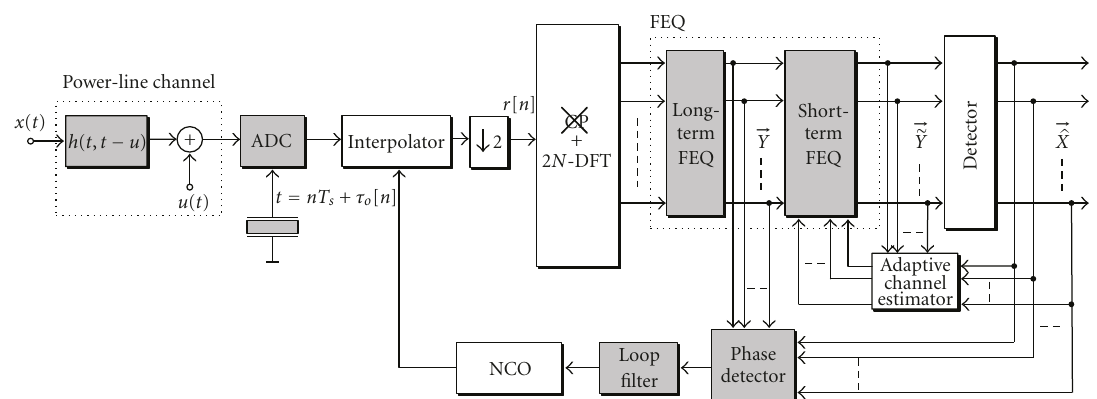
Figure 4: Simplified scheme of the DMT